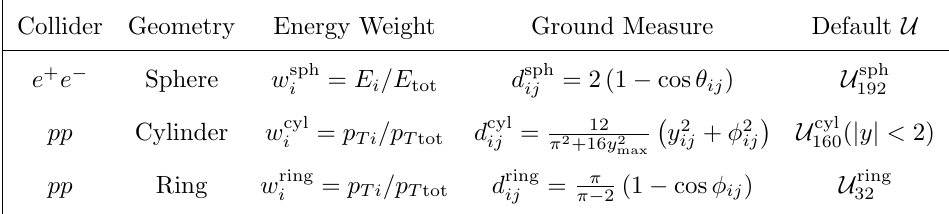
Table 1 . The three di(cid:11)erent event geometries used to de(cid:12)ne event isotropy in this paper, with their corresponding energy weights, ground measures, and default quasi-uniform con(cid:12)gurations. For the cylinder geometry, we must specify the rapidity range j y i j < y max . Note that p T tot is the scalar sum of the transverse momenta. These ground measures satisfy eq. (2.5) with (cid:12) =